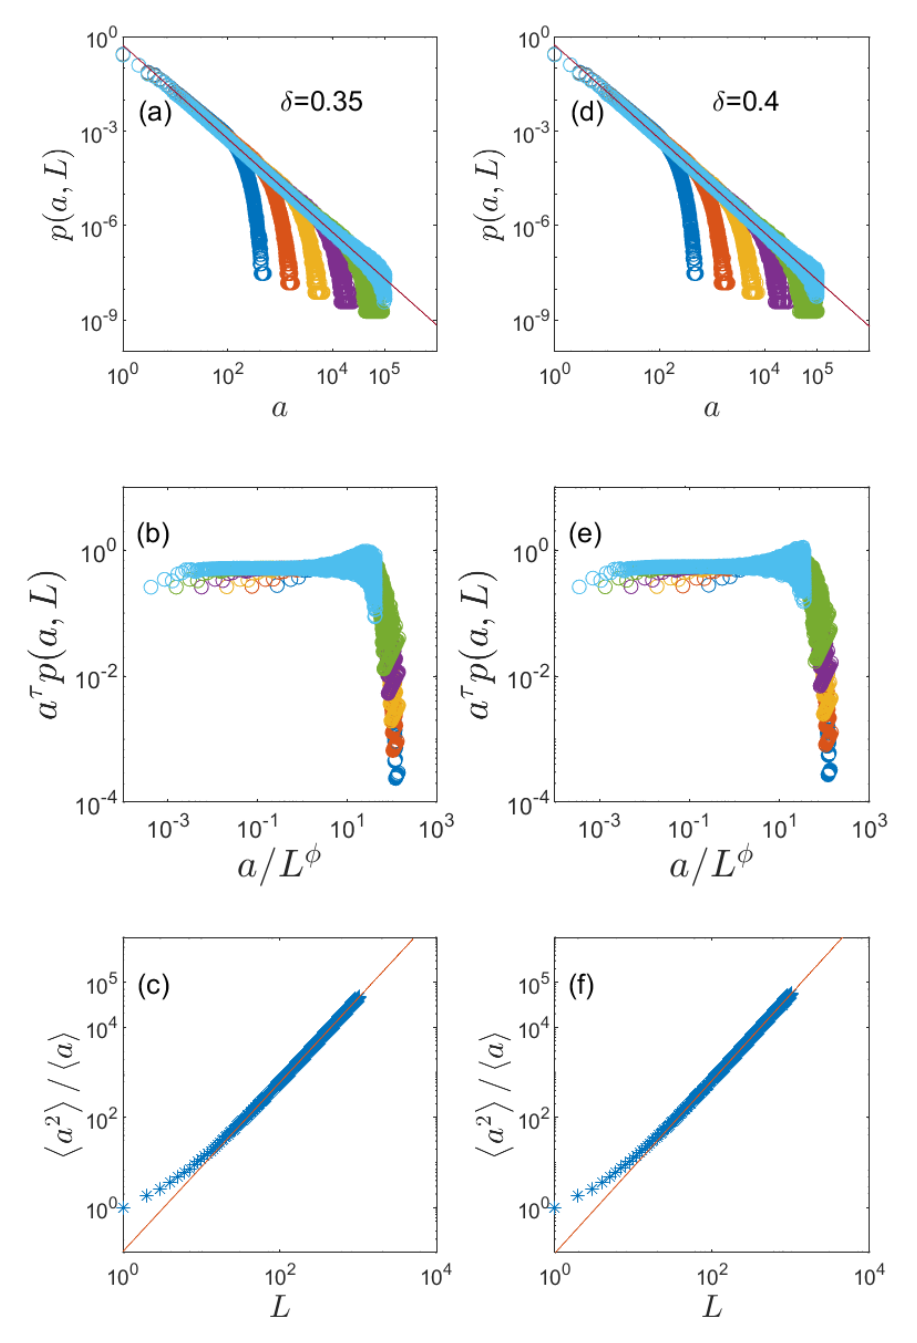
Figure 6. ( a ) The plot of the scaling function of p ( a , L ) for various values of L = 32,64,128,256,512, and 1024 from the left to the right for δ = 0.35. The straight guide line represents τ ≈ 1.48. In the figure ( b ), the data are very well collapsed with τ = 1.475 and φ = 1.87. The figure ( c ) shows the value of the exponent φ which has been obtained as φ ≈ 1.87 from the relation, A = The figure ( d ) shows the plot of p ( a ) for various values of L = 32,64,128,256,512, and 1024 for δ = 0.4. The straight guide line represents τ ≈ 1.49. The data are very well collapsed with τ = 1.49 and φ = 1.91 as shown in the figure ( e ) and in the figure ( f ) the value of the exponent phi was obtained as 0.91 by measuring the characteristic drainage